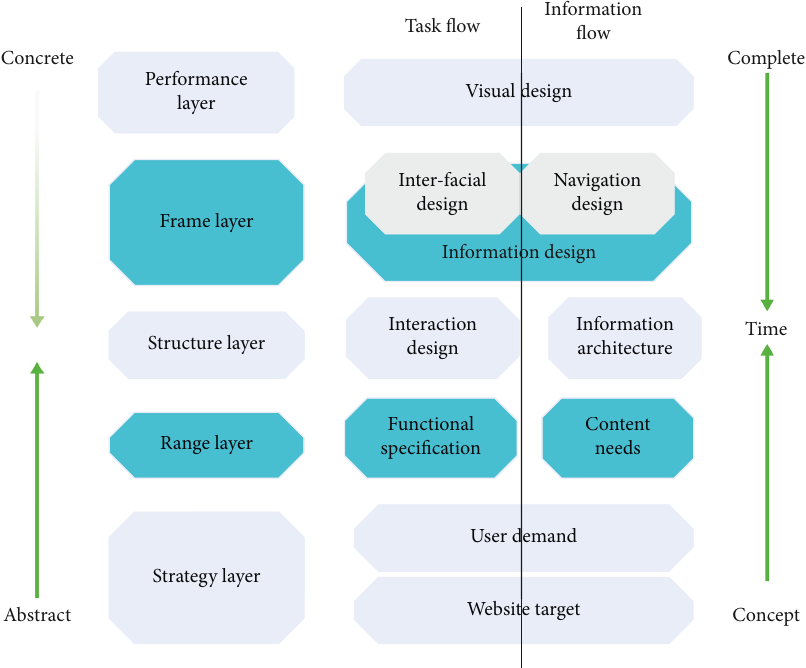
Figure 6: Five elements of user